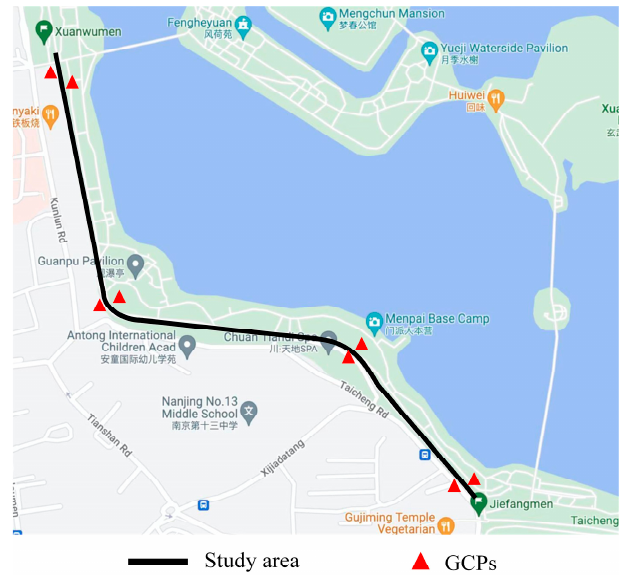
Figure 5. Ground control point distribution map.